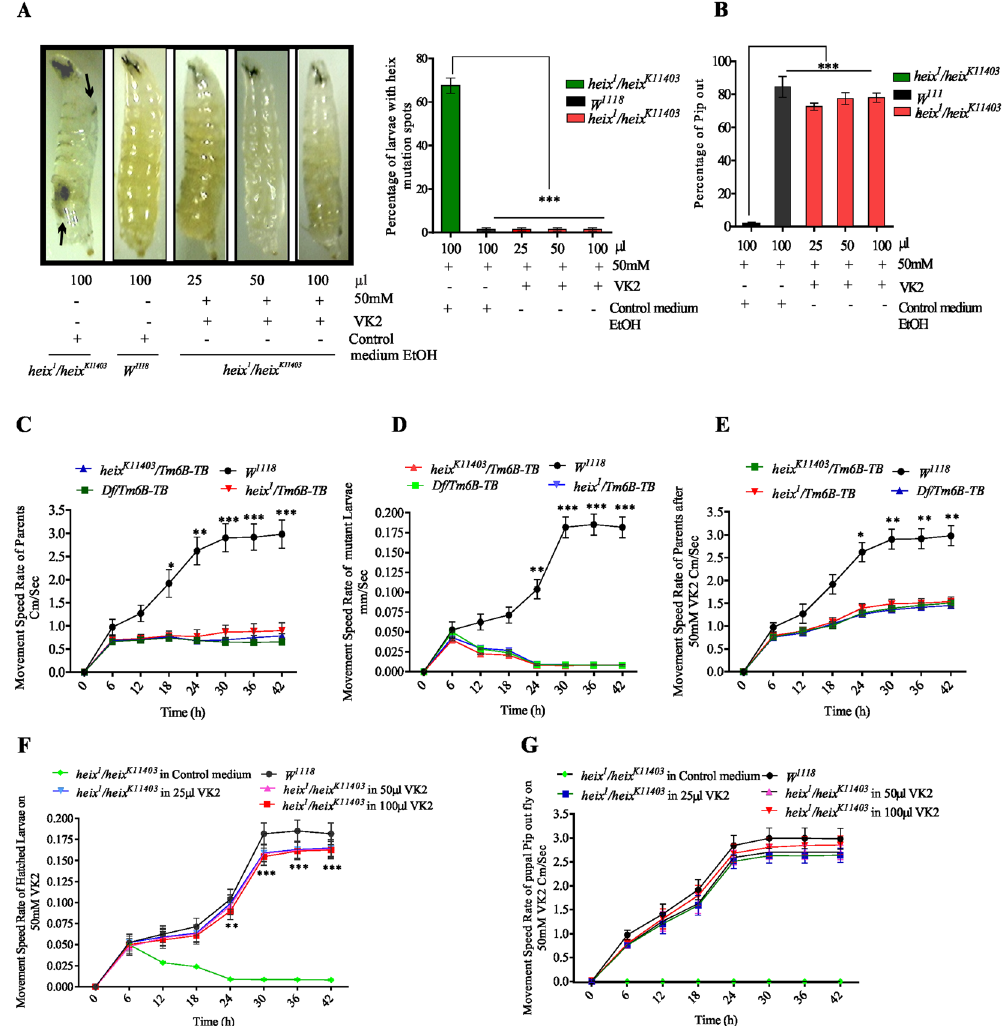
Figure 1. VK2 Prevents lymphoma in Drosophila . ( A ) Significant disappearance of black spots strongly evidenced with 25–100 µ l of 50 mM VK2 dose. ( B ) Improvement of Pupal pip out rate. ( C ) Movement speed of heix mutant parent flies before treatment. ( D ) Movement speed of heix mutant larvae before treatment ( E ) Improvement in movement speed of mutant parent flies after treatment. ( F ) Movement speed Improved in larvae born from treated parent flies. ( G ) Movement speed of piped out flies fed on vitamin K2. Control media contain 50 mM Ethanol (EtOH) and treatment media contain 50 mM VK2. Means normalized to control ( Canton S ). Error bars indicate SEM. Analysis of variance (ANOVA/Dunnett: * P < 0.05, ** P < 0.01, *** P <